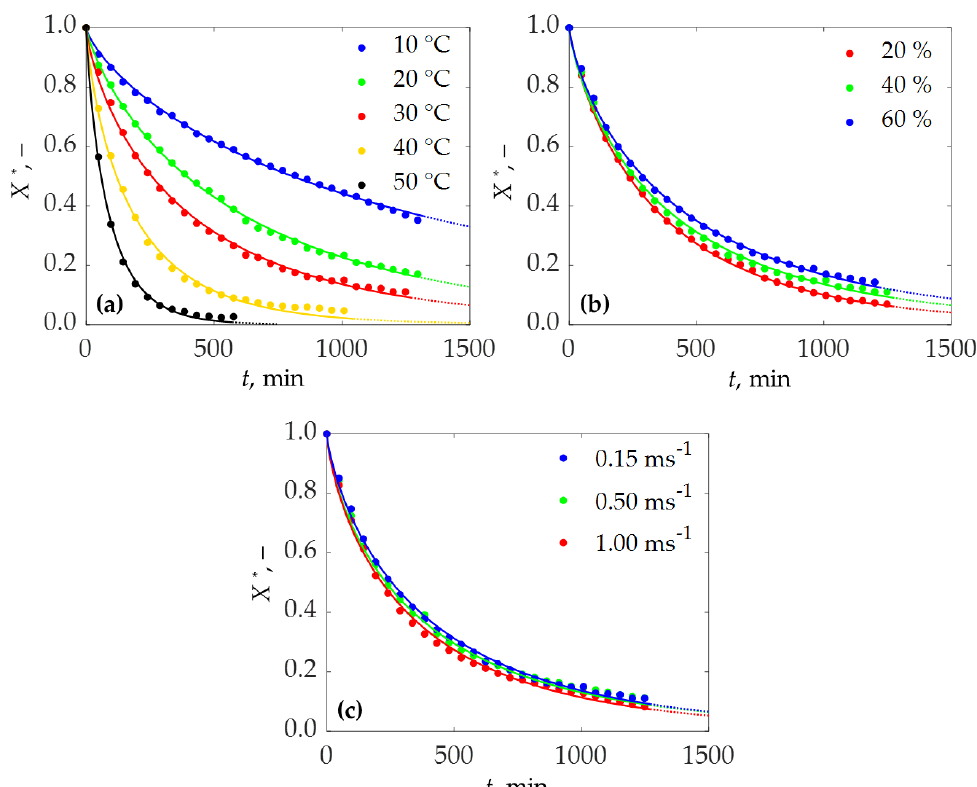
Figure 3. Moisture ratio X * vs. time t ; ( a ) temperature T ranging from 10 to 50 °C at relative humidity RH = 40%, airflow velocity v = 0.15 ms −1 ; ( b ) RH ranging from 20 to 60% at T = 30 °C, v = 0.15 ms −1 ; ( c ) v ranging from 0.15 to 1.00 ms −1 at T = 30 °C, RH = 40%. Solid lines represent Page model fitting, dashed lines show extrapolation beyond the dataset used for fitting.